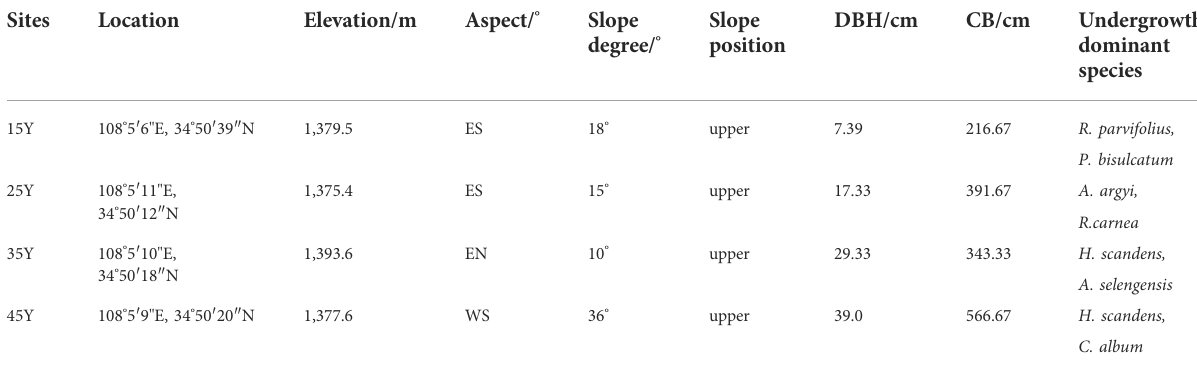
TABLE 1 The basic information about the sampling